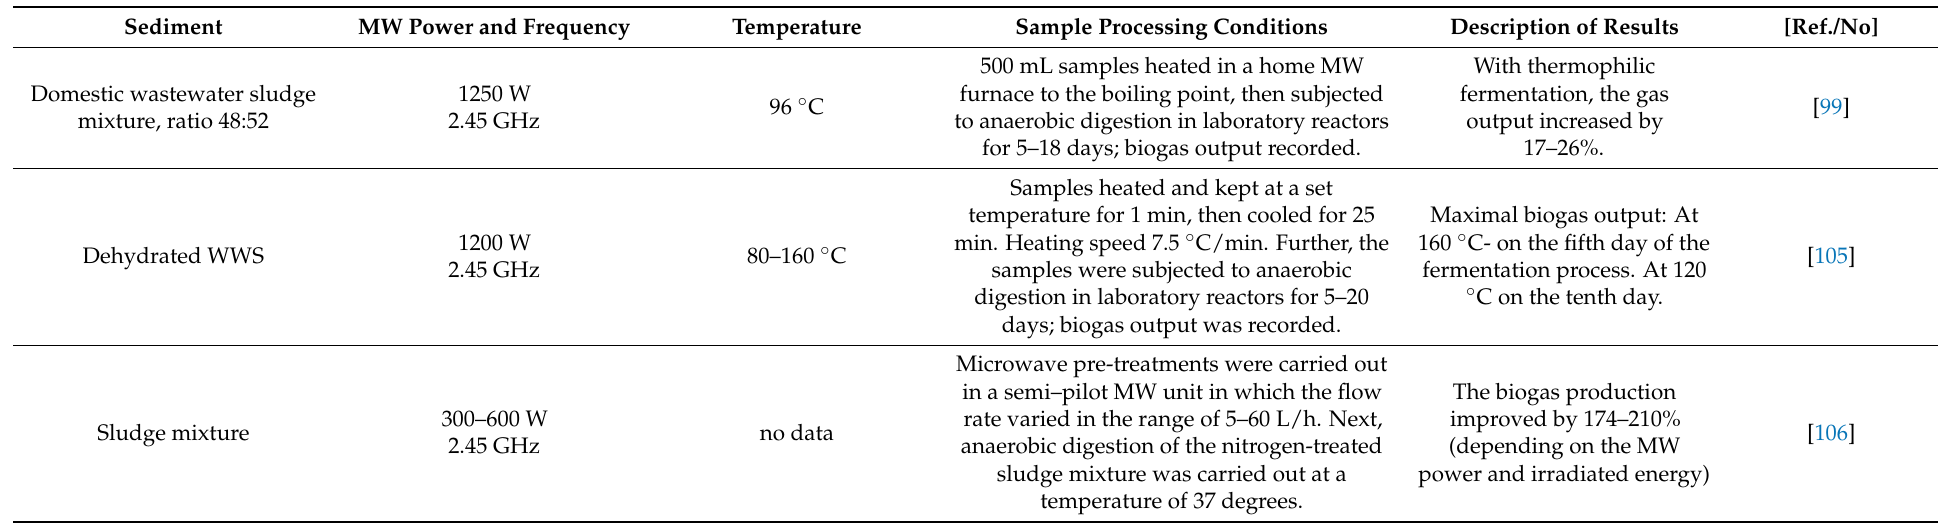
Table 9. Intensification of the biogas output during the MW treatment of